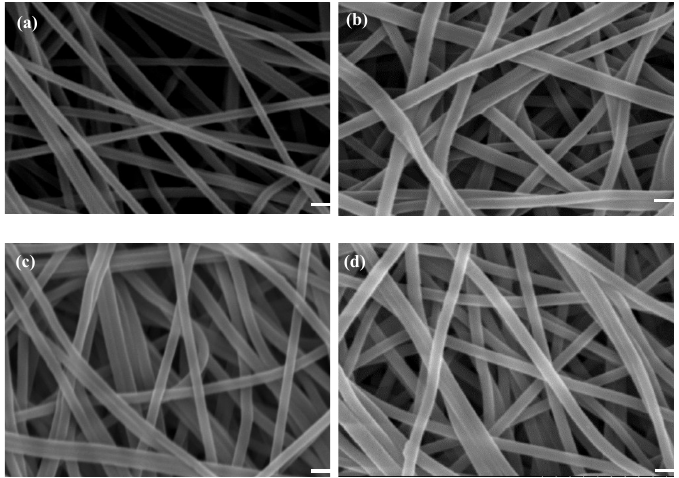
Figure 3. SEM images of ( a ) PAN, ( b ) P-COOH, ( c ) P-COOH-CS, and ( d ) P-COOH-CS-RG19. Bar scale: 1000 nm.